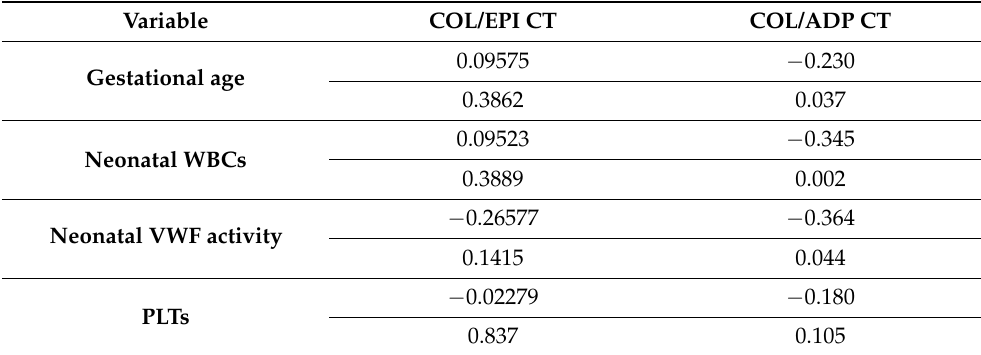
Table 4. Correlation of COL/EPI and COL/ADP CTs with clinical and other laboratory (arithmetic) parameters of neonates from GDM